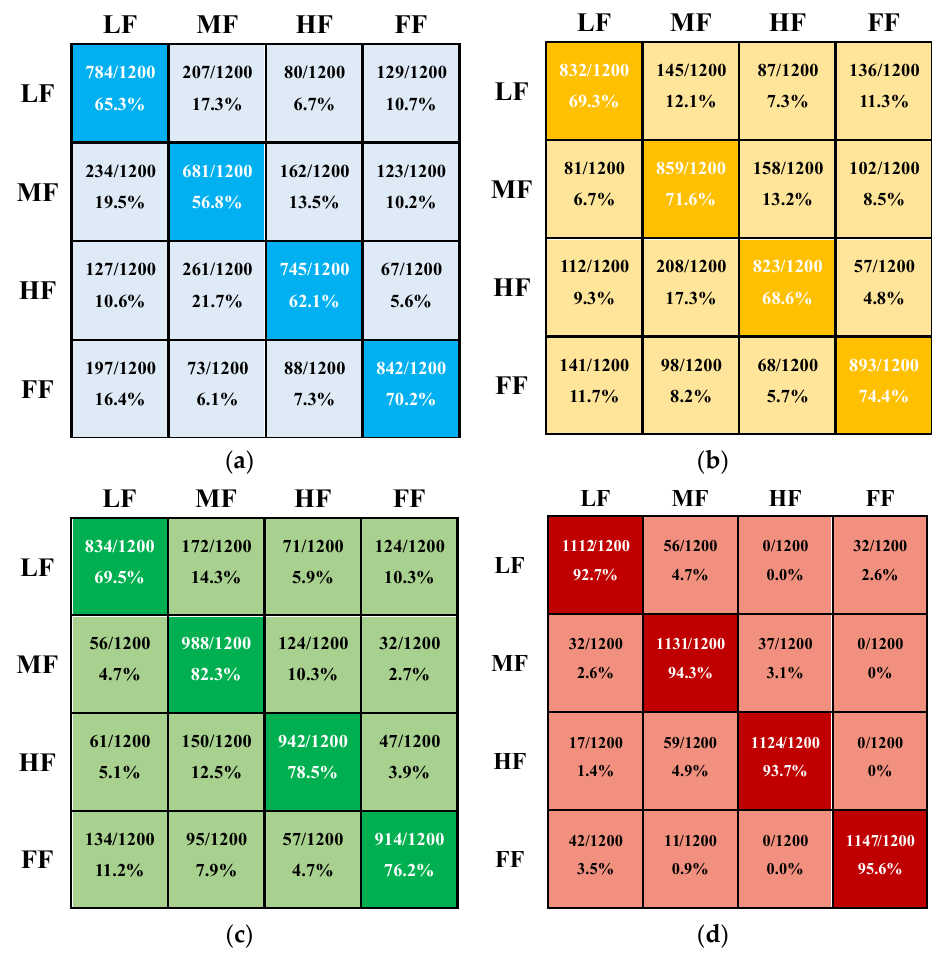
Table 6. Details of the Case Western Reserve University defective bearing dataset.